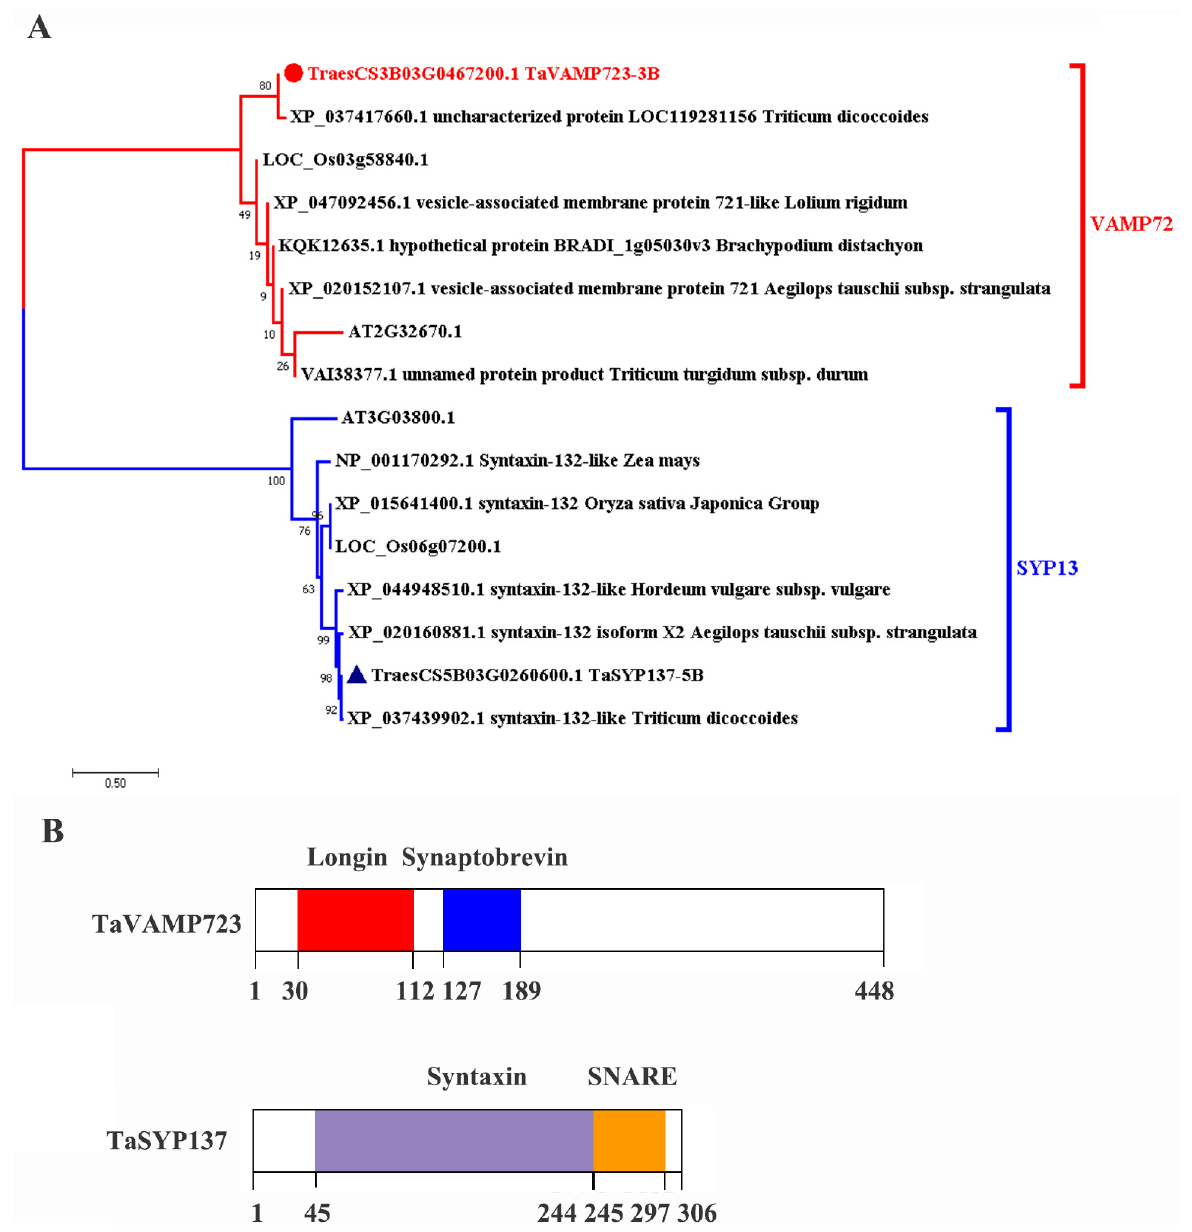
Figure 1. Analysis of TaVAMP723-3B and TaSYP137-5B . ( A ): Phylogenetic analysis of TaVAMP723